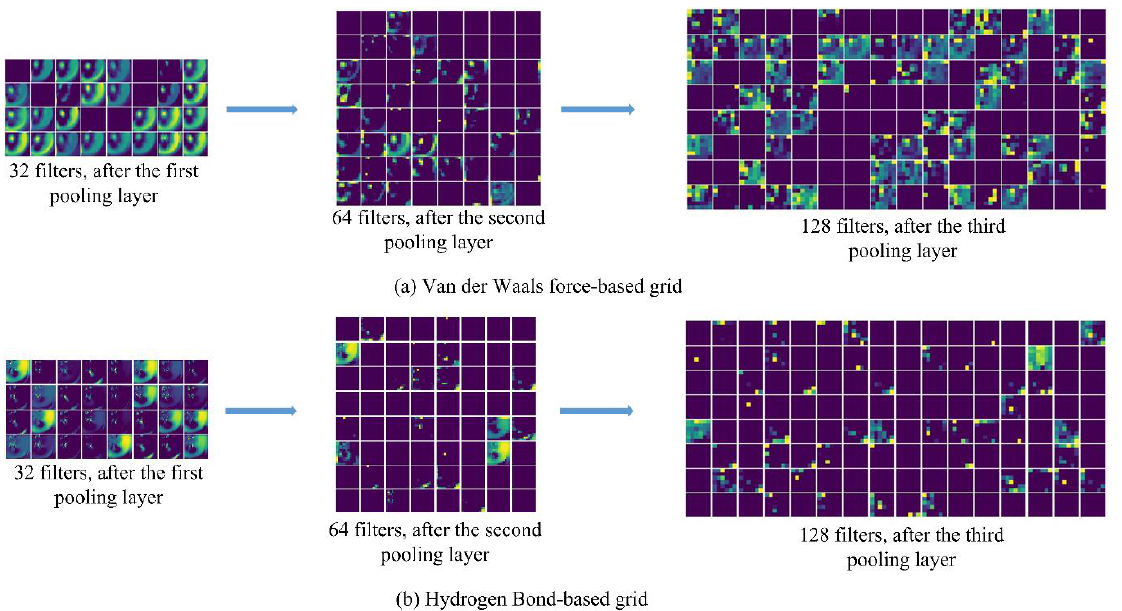
Figure 5. Visualization of training process. Three feature maps output after each pooling layer with different filters are displayed. The part ( a ) is grid from excluded volume, and the part ( b ) is grid from Hydrogen Bond.